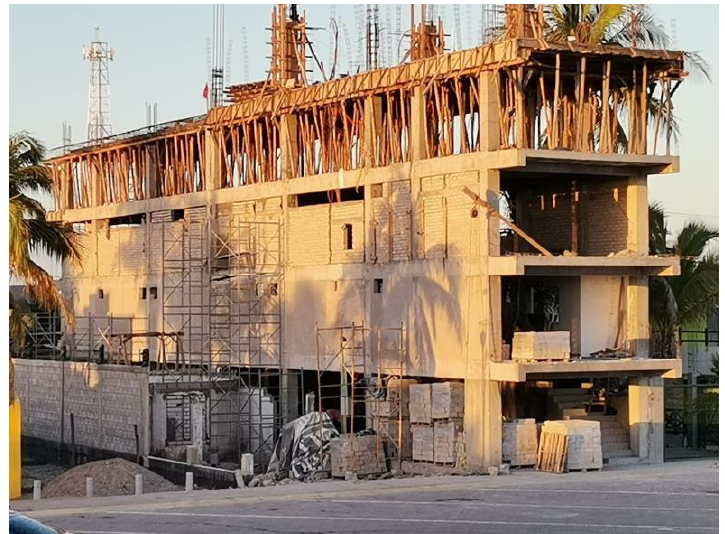
Figure 1. Mexican construction practice of masonry infill walls.